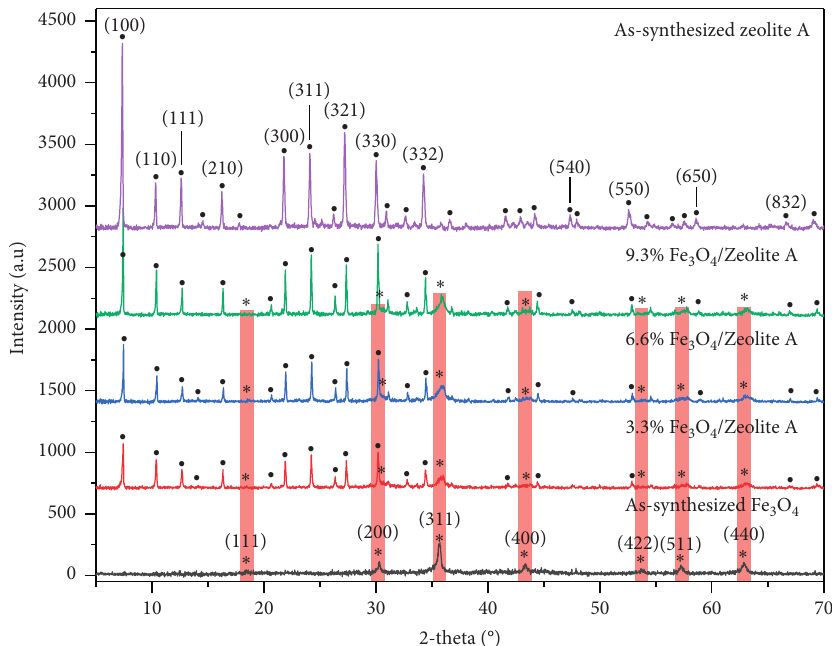
Figure 2: XRD patterns of ZA powder, Fe 3 O 4 NP, and Fe 3 O 4 /ZA nanocomposite samples with different Fe 3 O 4 NP loadings (wt. characteristic peaks centered at 2 θ ∼ 18.8 ° , 30.3 ° , 35.6 ° , 43.5 ° , 57.3 ° , and 63.2 ° corresponds to (111), (200), (311), (400), (511), and (440) planes of Fe O crystalline phase (JCPDS 3 4